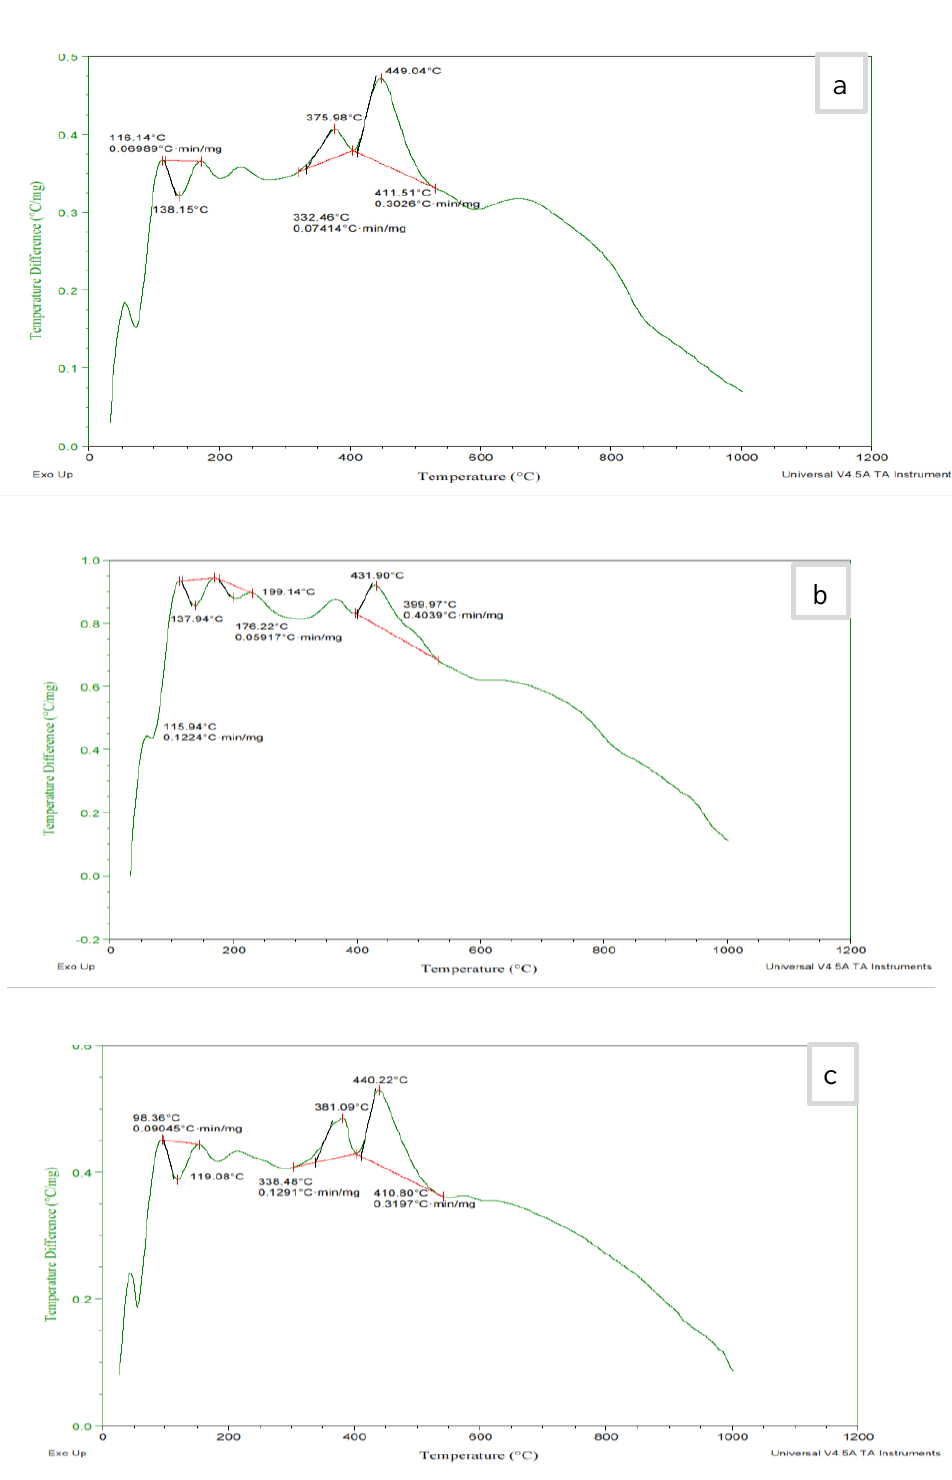
Figure 7: DSC for blend and nanocomposites: a. blend, b.1%Gr, and c. 7%